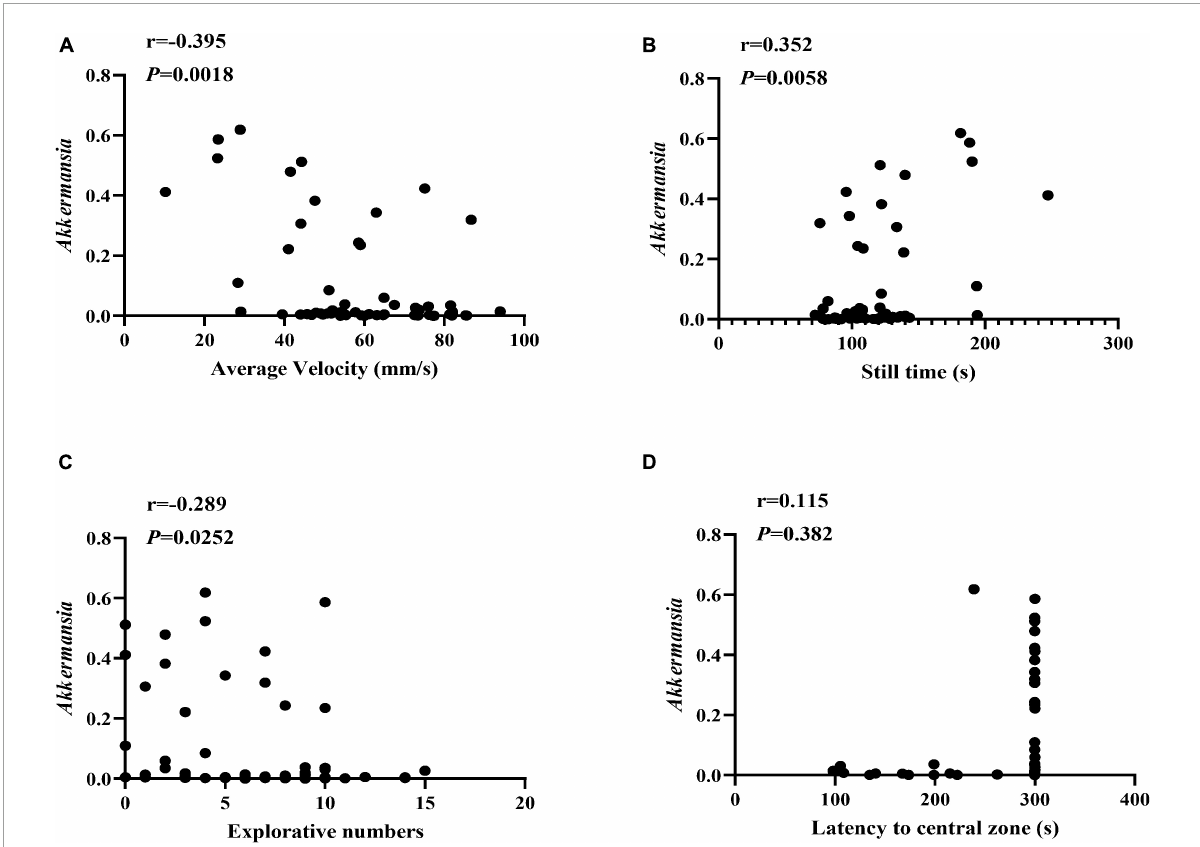
FIGURE6 The correlation between Akkermansia and the behavior performance. (A–D) The Spearman correlation analysis between the relative abundance of Akkermansia and the average velocity, still time, explorative numbers, and latency to the central zone, respectively. The correlation coefficients (r) and the P value were shown in the top